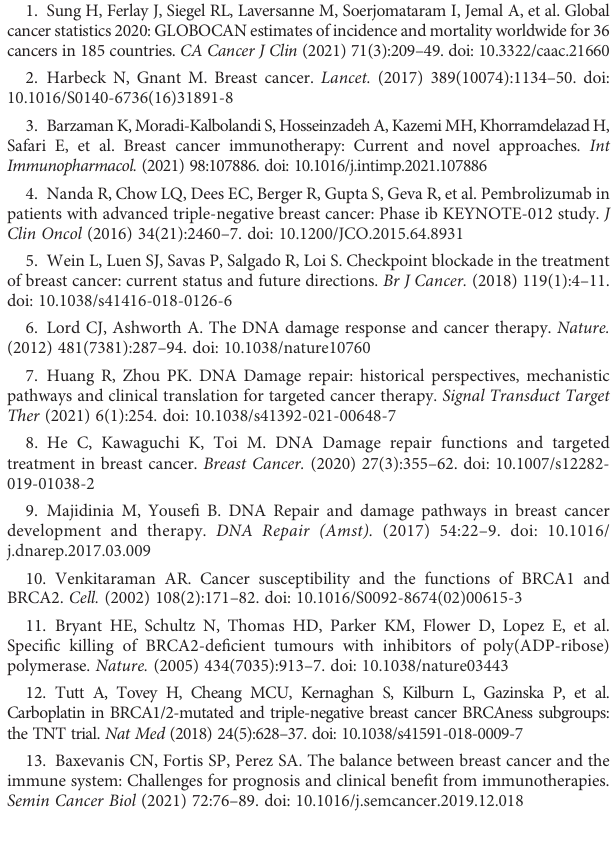
SUPPLEMENTARY FIGURE 1 Validation of the prognostic performance of the signature in various clinicopathological subgroups in cohorts TCGA-BRCA (A) , GSE96058 (B) and GSE20685 (C) . SUPPLEMENTARY FIGURE 2 Cox regressions identi fi ed the DNA damage repair-related signature capable of acting as an independent prognostic indicator for PFS, DFS and DSS in TCGA-BRCA cohort. SUPPLEMENTARY FIGURE 3 Differences in cancer hallmark-related scores between risk groups. (A) Heat map of correlation between risk scores and hallmark signatures. The color from blue to red represents the score from low to high. (B, C) Differential hallmark-related signature scores between risk groups. (ns: not signi fi cant, * P < 0.05, ** P < 0.01, *** P < 0.001). SUPPLEMENTARY FIGURE 4 Association between the risk signature and BRCA1/2 mutations. (A) Frequency and pattern of BRCA1/2 mutations in BRCA patients in the TCGA cohort. (B) Survival differences between the high- and low-risk patients in different BRCA1/2 mutation subgroups. (C) Differences in TIDE scores between the high- and low-risk patients with wild-type BRCA1/2 or mutant BRCA1/2. (* P < 0.05, ** P < 0.01, *** P < 0.001). SUPPLEMENTARY FIGURE 5 Correlation between risk scores and IC50 values of the 10 chemotherapeutic drugs mentioned above. SUPPLEMENTARY FIGURE 6 Analysis of external datasets demonstrated poor prognosis of BRCA patients with high expression of GNPNAT1 (A) or MORF4L2 (B)